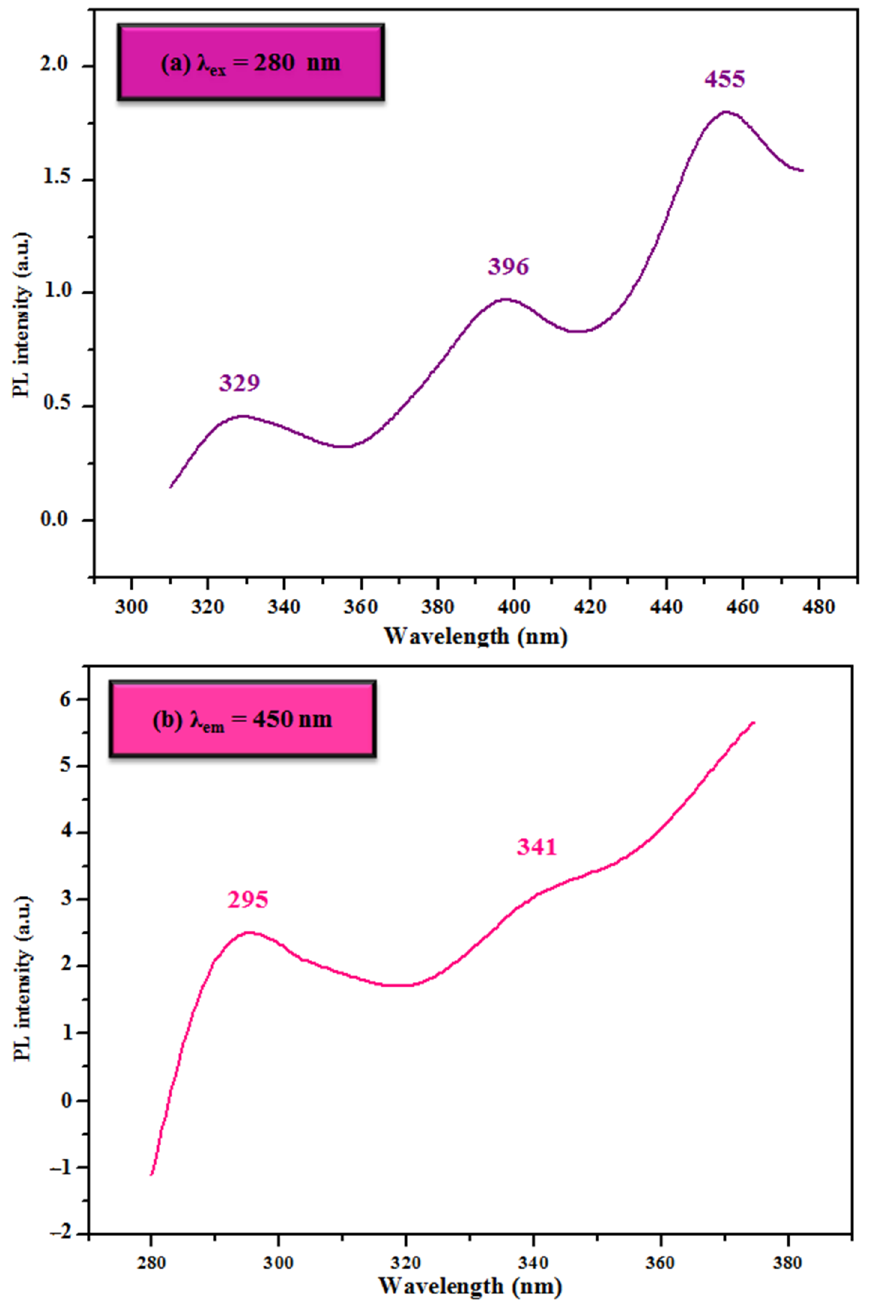
Figure 10. PL spectrum of (C 5 H 14 N 2 )[HgCl 4 ]·H 2